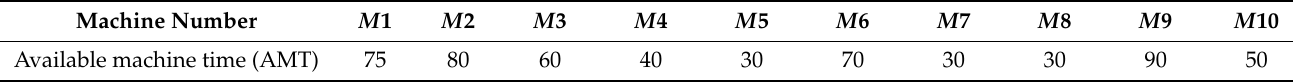
Table 8. Available machine time of each machine in the knuckle joint assembly.